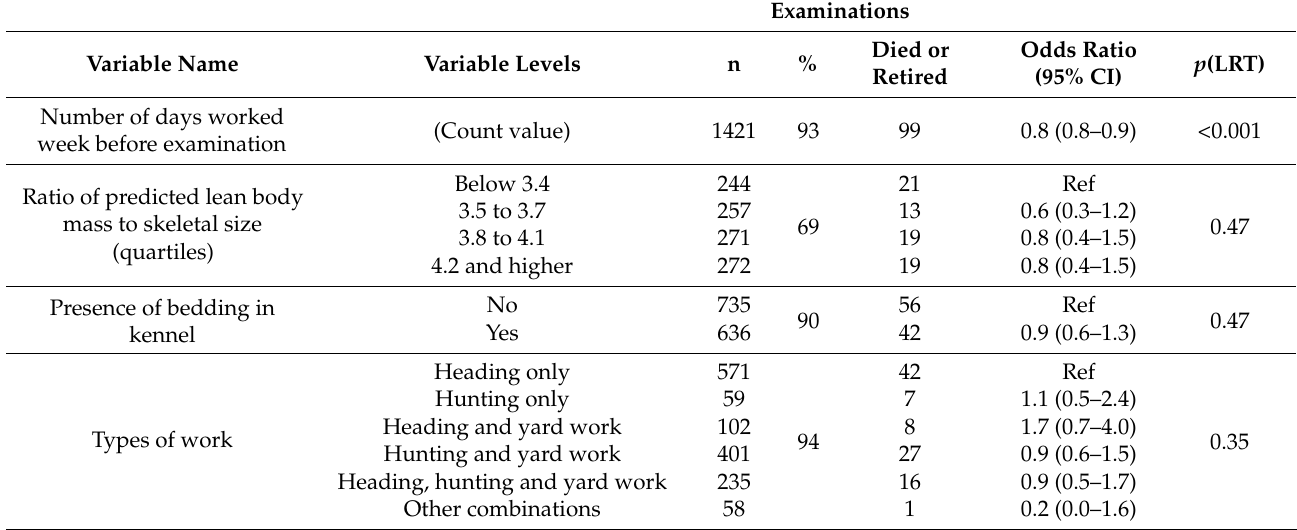
Table 6. Number and percentage of examinations that had a recorded value for the respective variable. Odds ratios were calculated from the β -coefficients of univariable logistic regression models examining the association between potential explanatory variables and the risk of examinations being followed by dogs dying or being retired. p -values were derived from log-likelihood ratio tests of the same models. The listed explanatory variables were not included in multivariable analysis as they had recorded values in less than 95% of examinations. Data are from 1522 examinations of 613 dogs that were enrolled in the TeamMate project.